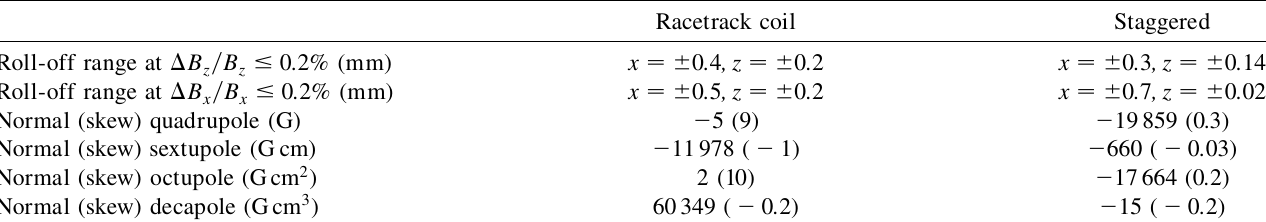
FIG. 6. (Color) Roll-off (cid:17) B=B as functions of distance along the transverse axis: (a) and (b) field homogeneity of (cid:17) B (cid:3) x; z (cid:4) =B (cid:3) 0 ; 0 (cid:4) of the racetrack coil undulator and (c) and (d) of the staggered undulator. and (cid:17) B z z